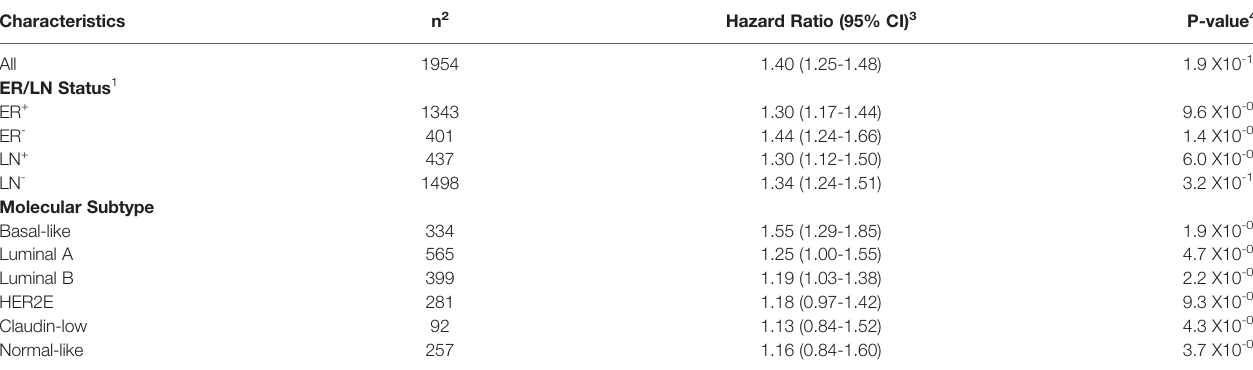
TABLE 1 | Cox proportional hazards regression analysis of TREM1 in clinical and molecular subtypes of the MC1 cohort.